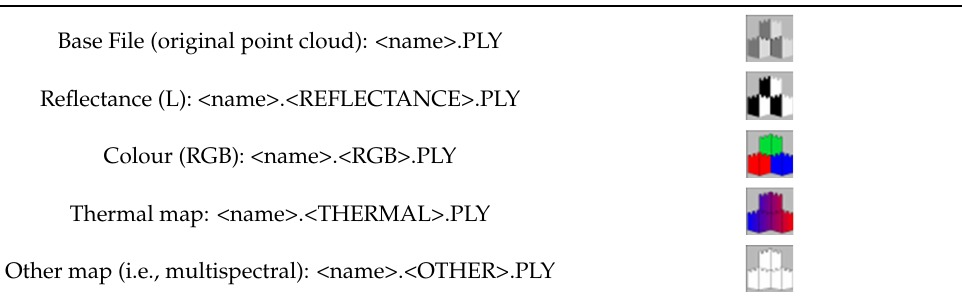
Table 2. Naming of the LOKI tool for loading and handling